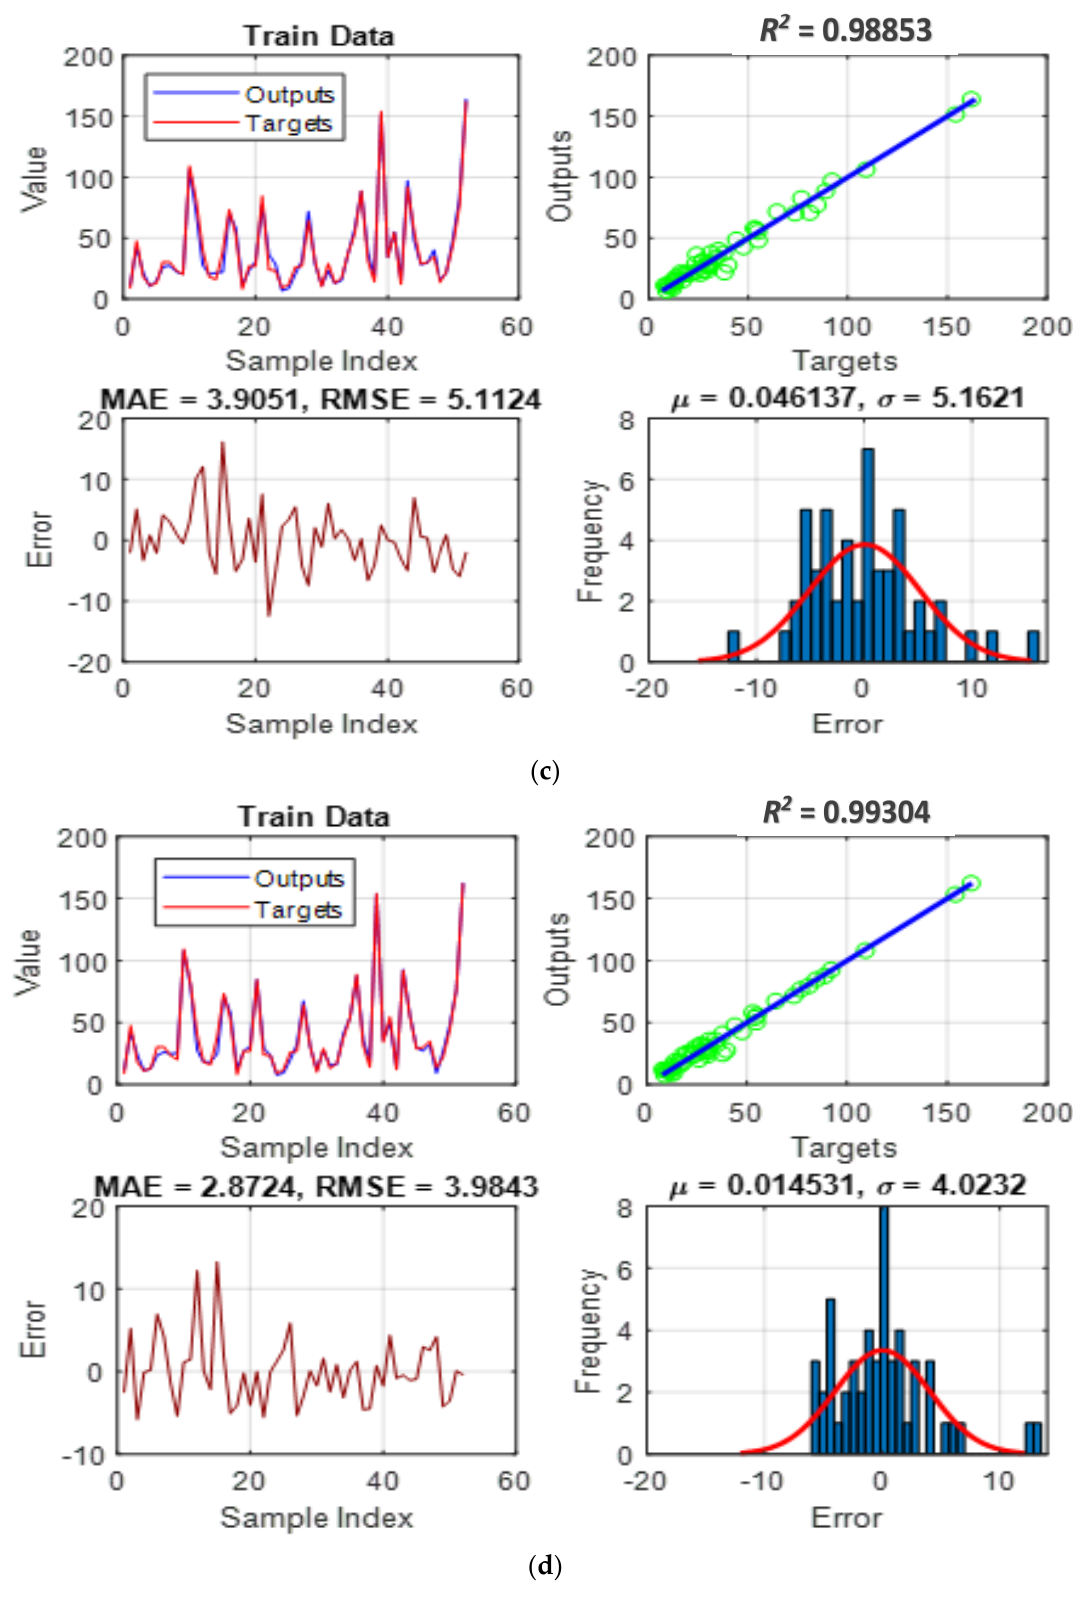
Figure 4. Training results of the ( a ) HHO – ANFIS, ( b ) SSA – ANFIS, ( c ) TLBO – ANFIS, and ( d ) WCA – ANFIS.